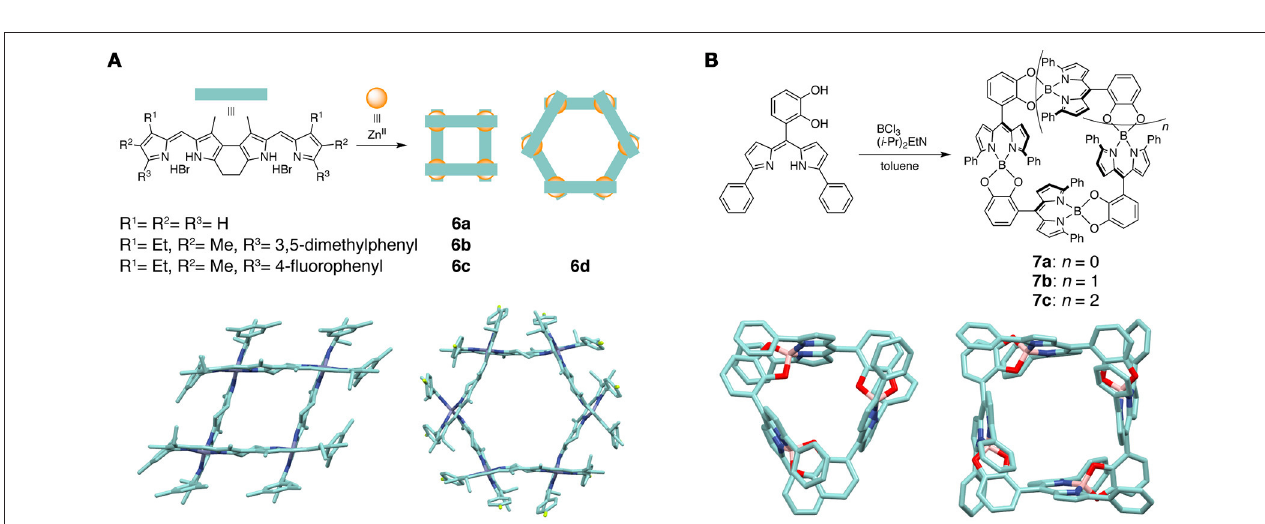
FIGURE 4 | (A) (top) Schematic illustration showing the synthesis of grid-type rhombic ( 6a – 6c ) and hexagonal ( 6d ) supramolecular macrocycles. (bottom) Molecular structure of 6b (left) and 6d (right) determined by X-ray crystallography. Hydrogen atoms are omitted for clarity. (B) (top) Synthetic scheme of macrocyclic complexes 7a – 7c . (bottom) Molecular structure of 7a (left) and 7b (right) determined by X-ray crystallography. Hydrogen atoms are omitted for clarity.